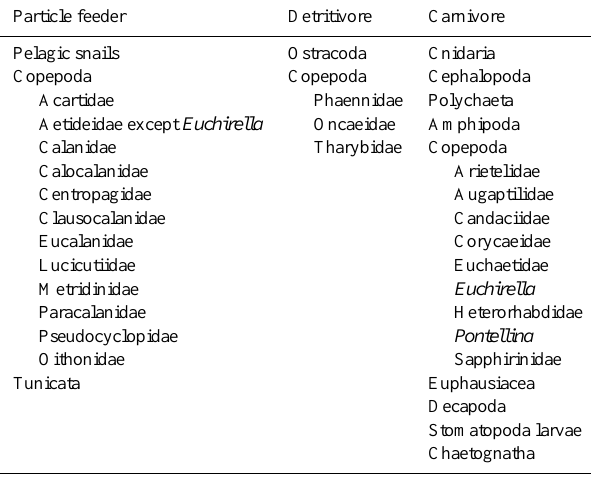
Fig. 5. Kitamura et al.